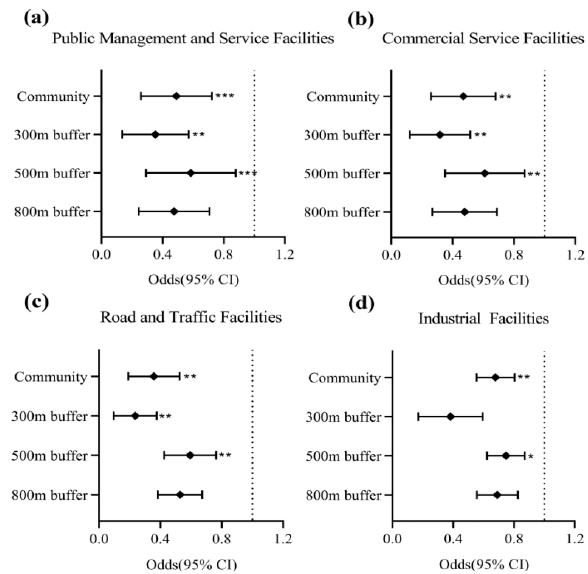
Figure 5. Results of sensitivity tests with the MGSEMs on the association between different types of built environments and hypertension. Note: ① ( a ): sensitivity analysis of public management and service facilities in different living circles; ( b ): sensitivity analysis of commercial service facilities in different living circles; ( c ): sensitivity analysis of road and traffic facilities in different living circles; ( d ): sensitivity analysis of industrial facilities in different living circles. ② Symbols denote probability, and bars denote 95% CI. Significance levels: * p < 0.05, ** p < 0.01 and *** p < 0.001.